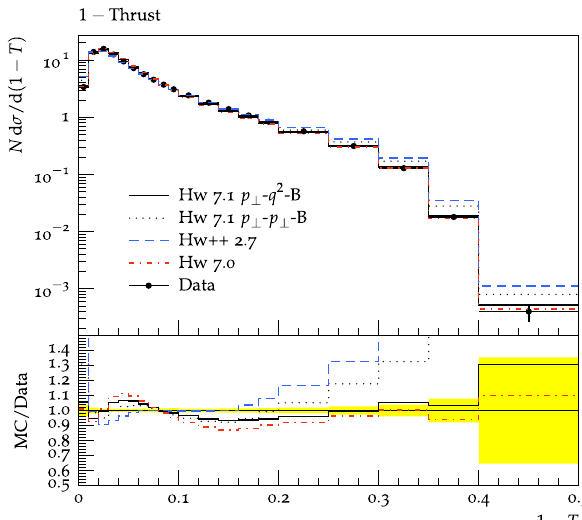
Fig. 8 Differencebetweenthechargedmultiplicityinbottomandlight quark events in e + e − collisions as a function of centre-of-mass energy. The data is from [60,62–64,74,80–89] as compiled in [90]